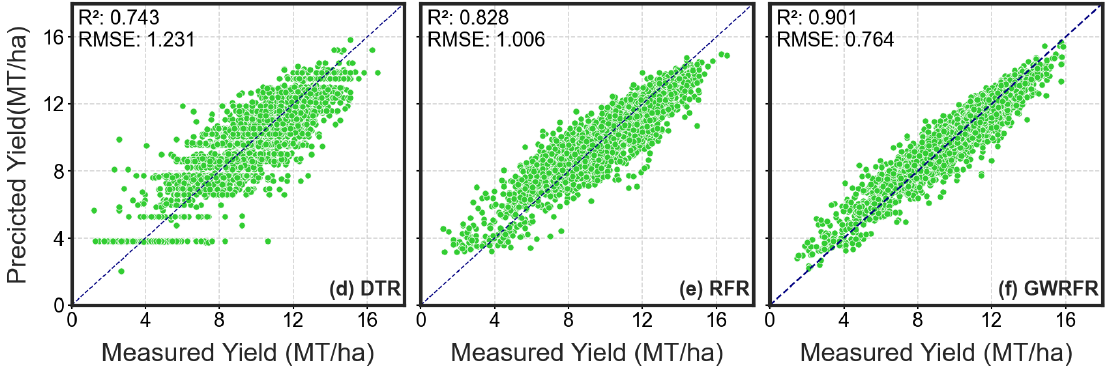
Figure 5. The scatterplots of the actual yield and the predicted yield derived from ( a ) MLR, ( b ) PLSR, ( c ) SVR, ( d ) DTR, ( e ) RFR, and ( f ) GWRFR using full-length features.